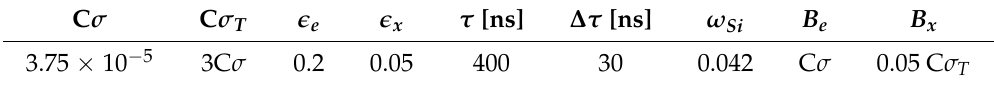
Table A2. The values for the parameters used in the calculation of SNR when masking the